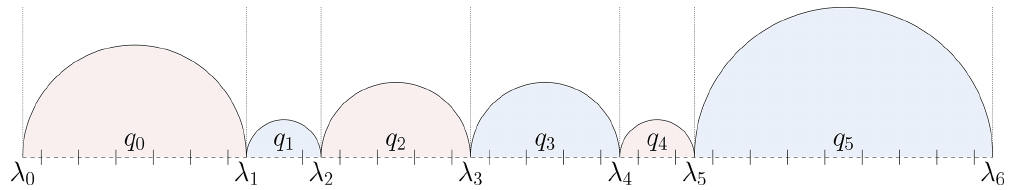
Figure 2. Example of a source term partition: (cid:51) = (λ 0 ,...,λ 6 ) is the set of boundaries, and q = (q 0 ,...,q 5 ) is the vector of release rates. The release rate defined on the time interval [ λ 2 ,λ 3 ] is constant and equal to q 2